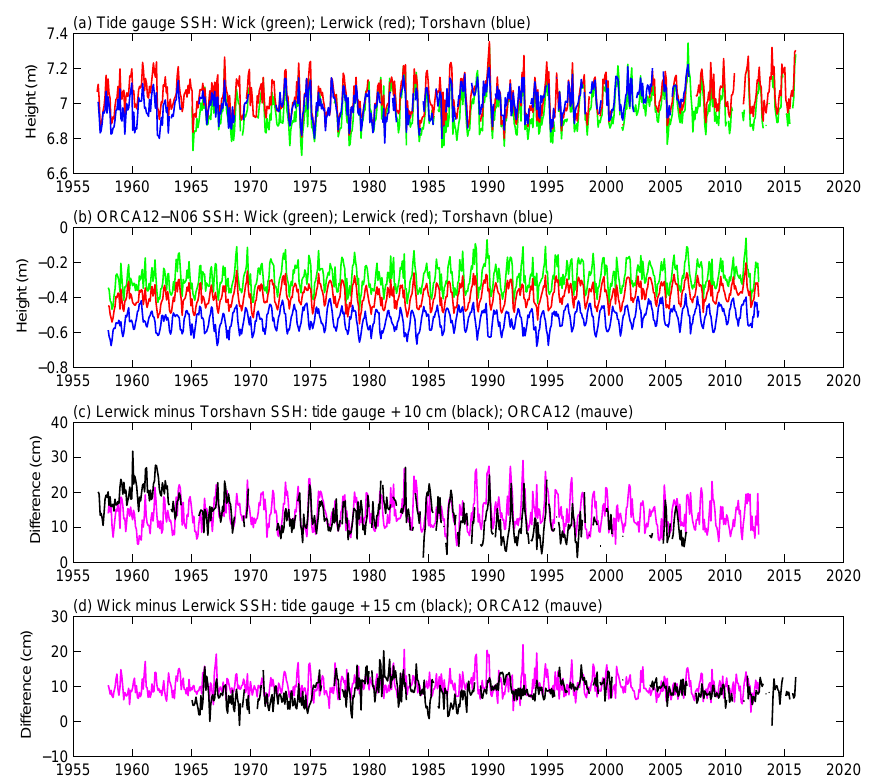
Figure 15. Sea surface height at Wick, Lerwick and Tórshavn: (a) relative sea level (monthly means) from tide gauge records (1957 onwards); (b) relative sea surface height (30-day running means) in ORCA12-N06 (1958–2012); (c) Lerwick minus Tórshavn differences; and (d) Wick minus Lerwick